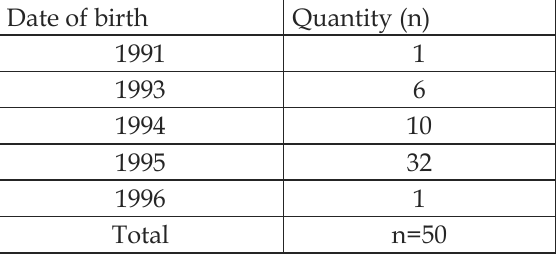
Table 4 . Age distribution in the research sample Date of